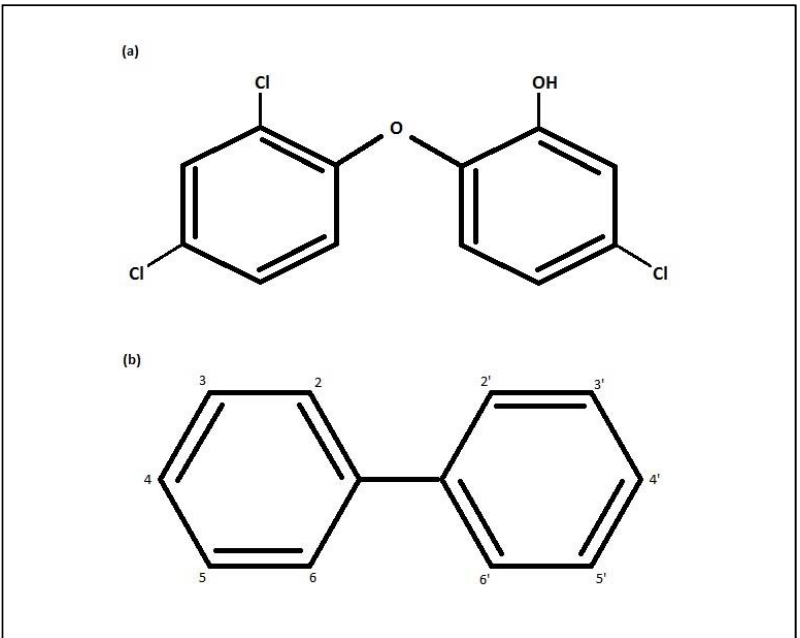
Figure 1. Chemical Structures of: ( a ) Triclosan and ( b ) Polychlorinated